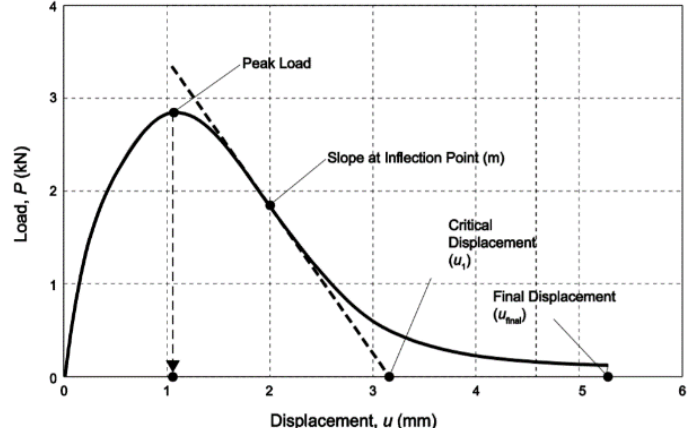
Figure 6. SCB test: ( a ) schematic diagram of pre-cut seam length; ( b ) test photo. For the SCB test, a semi-cylindrical shaped mixture specimen was placed in universal testing machine, and then the load was added by the upper metal column (Figure 6b). The test was conducted at 25 °C, while the loading speed was 50 mm/min, and the loading- deformation curve was recorded (Figure 7). The flexibility index can be expressed by Equations (6) and (7).